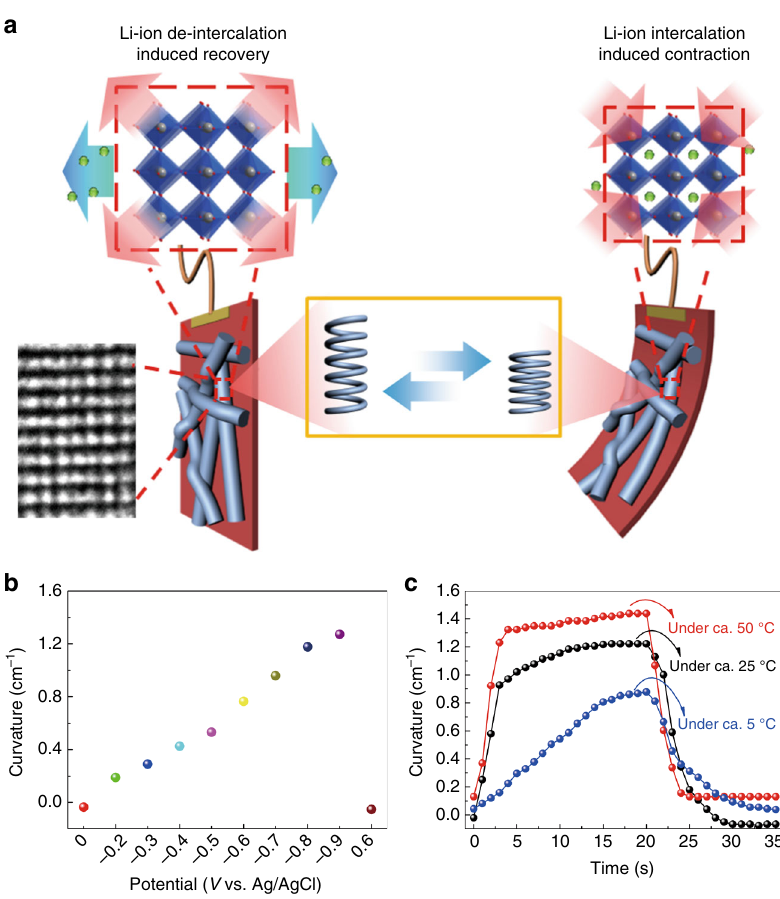
Fig. 5 The mechanism and tunability of pseudocapacitive actuation. a Schematic illustration of actuating mechanism of the dual-responsive fi lm in 1 M LiClO 4 / propylene carbonate (PC) electrolyte. b Maximum curvatures of the dual-responsive fi lm as function of the applied potentials. c Deformation responses of the dual-responsive fi lm measured at + 0.6 and − 0.9 V bias under different temperatures (~50, ~25 and ~5